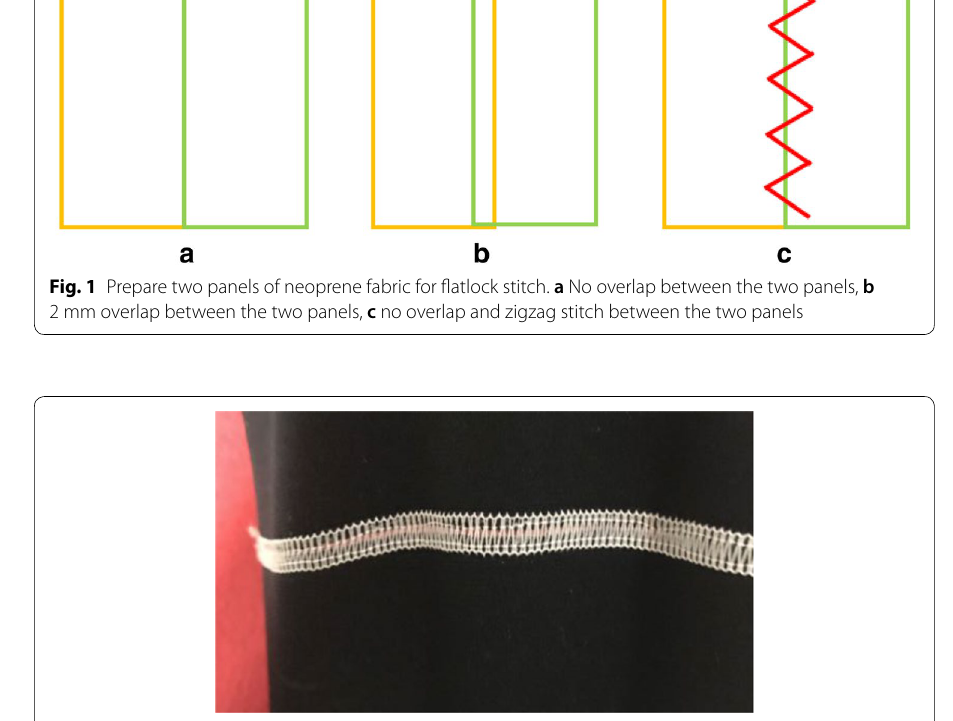
Fig. 2 Surface after pulling the flatlock stitch in the horizontal